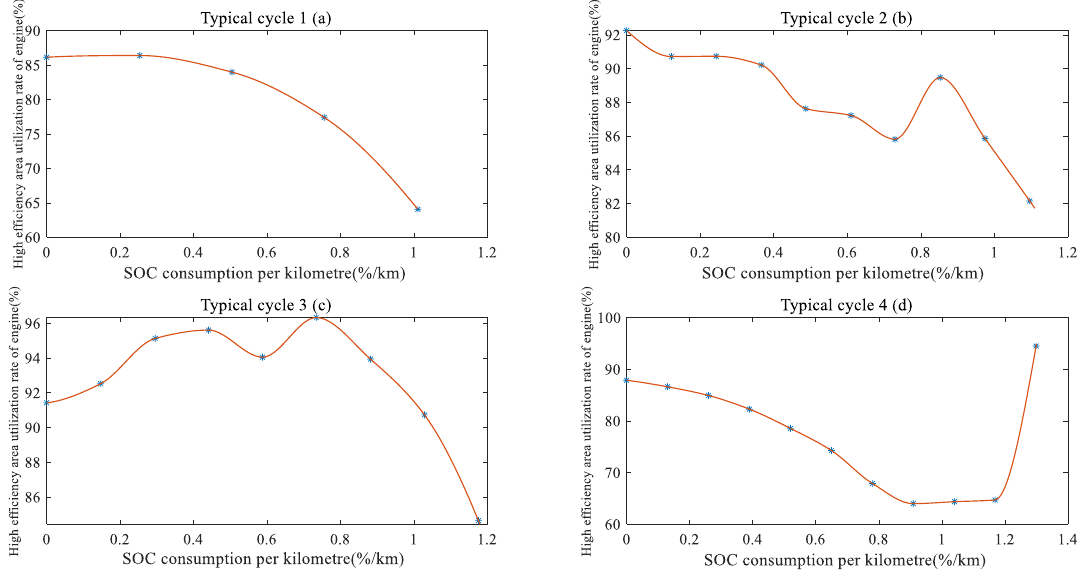
Figure 8. Relationship curve between SOC consumption per kilometer and high efficiency area utilization rate of engine under four typical cycles. ( a ) typical cycle 1; ( b ) typical cycle 2; ( c ) typical cycle 3; ( d ) typical cycle 4.